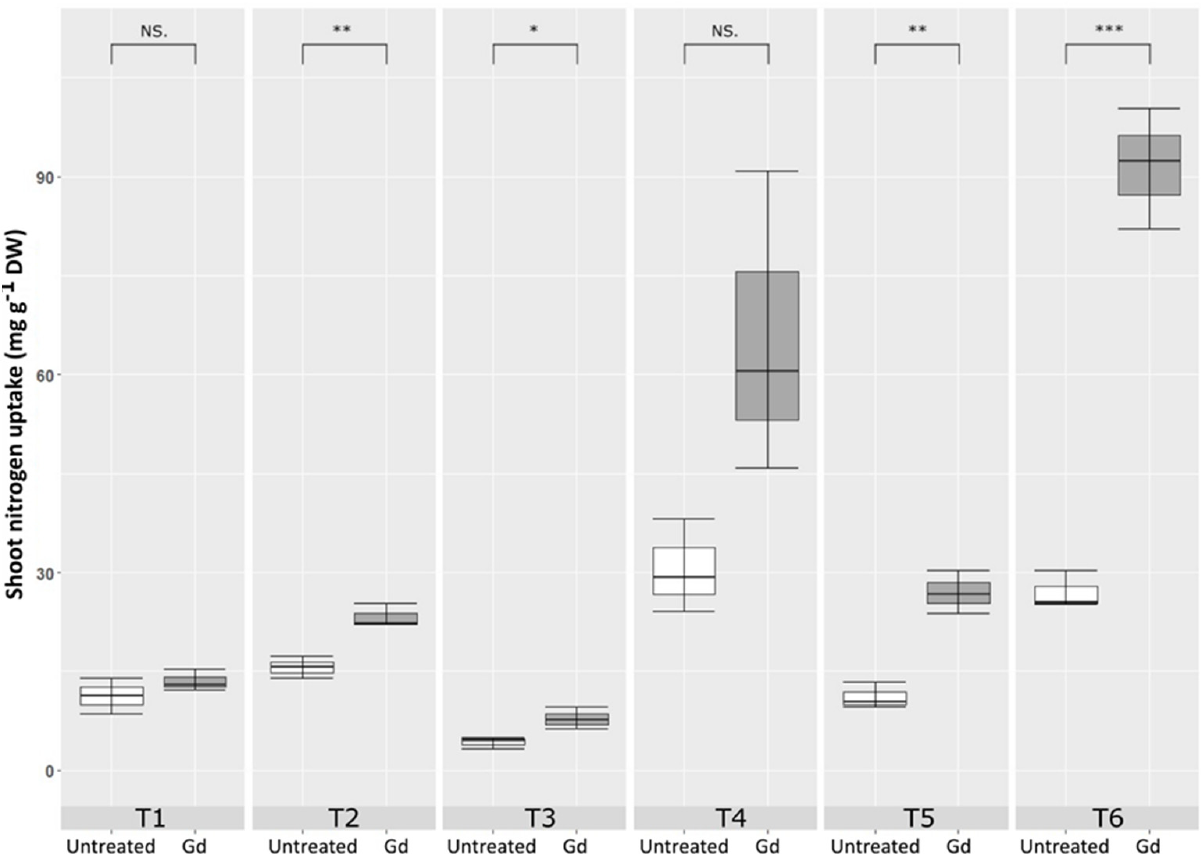
Figure 5. Evaluating the effects of severe water stress (35%-WHC; T1), moderate water stress (50%-WHC; T2), severe nitrogen stress (0 mg N pot − 1 ; T3), moderate nitrogen stress (150 mg N pot − 1 ; T4), combination of severe water stress and moderate nitrogen stress (35% WHC and 0 mg N pot − 1 ; T5), and combination of moderate water stress and moderate nitrogen stress (50% WHC and 150 mg N pot − 1 ; T6) on carotenoids of maize plants inoculated with Gluconacetobacter diazotrophicus Pal5 (Gd) in comparison with untreated plants. Shoot nitrogen uptake is given in milligram per gram of dry weight (mg · g − 1 · DW) of plants. Boxplots show the third quartile and first quartile (box edges), median (middle line) and range of the